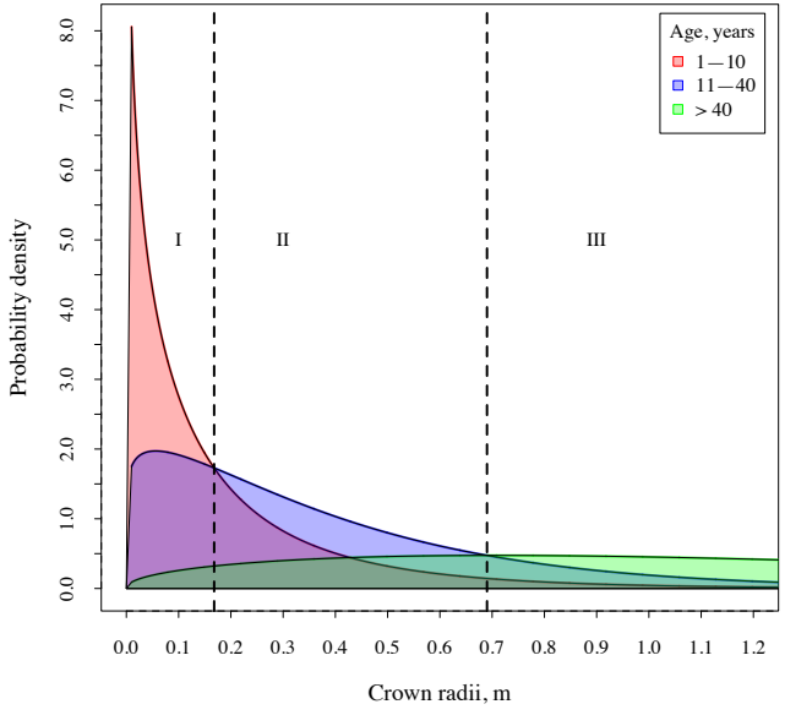
Figure 3. Proba- bility density graphs for the val- ues of average crown radius measured for Si- berian larch speci- mens on sample plots for three age intervals. Vertical lines mark inter- section points of the lines, breaking the range of ra- dius values into three areas based on probability of a specimen